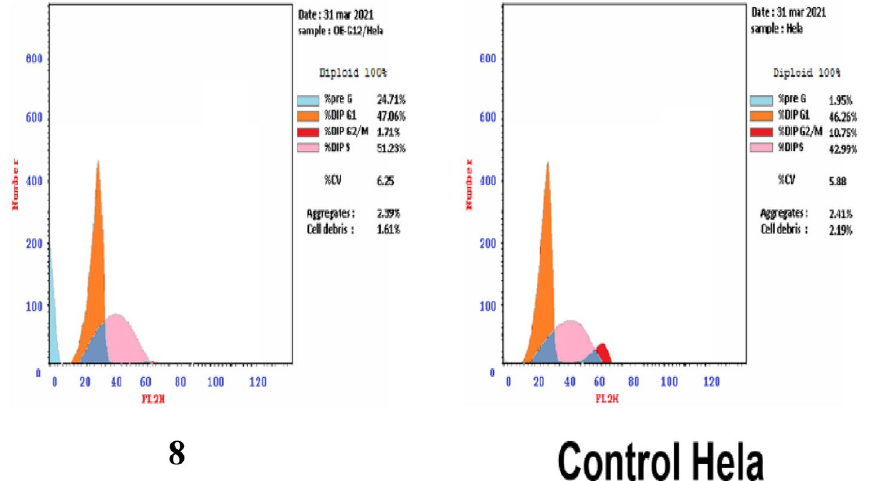
Figure 4. Effect of compound 8 on the cell cycle distribution of Hela